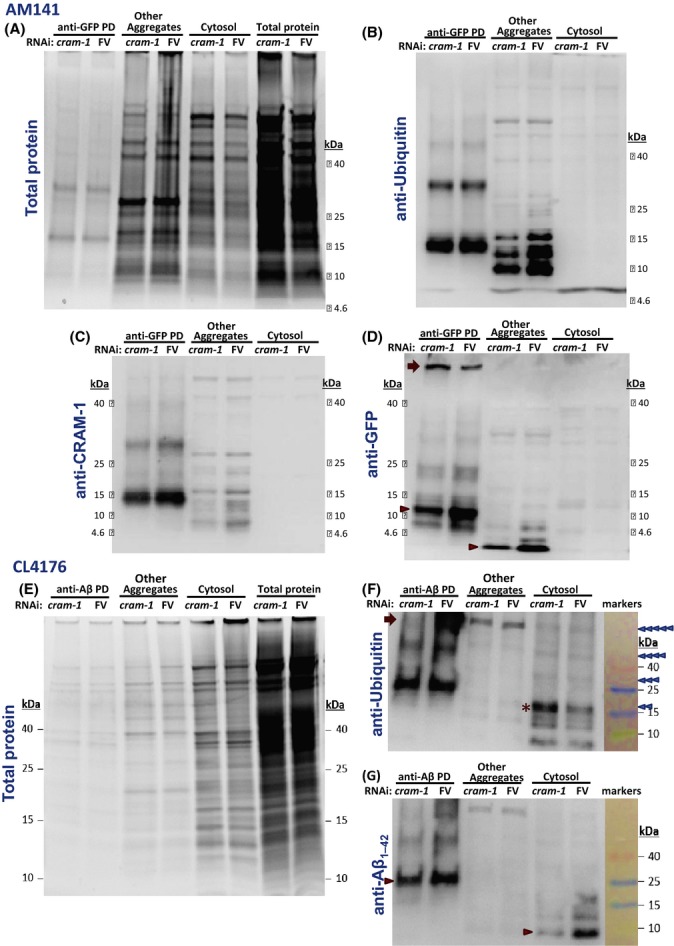
Western blot analyses of aggregated proteins from worms expressing Aβ1–42 or Q40::YFP. (A–D) AM141 worms, expressing Q40::YFP in muscle, were fed cram-1 dsRNA or FV bacteria. Aggregates were isolated and fractions resolved in gradient gel lanes (8–12%, Invitrogen). Proteins were stained with SYPRO Ruby (A), or electro-blotted to nylon membranes and probed with antibodies raised to ubiquitin (B), CRAM-1 synthetic peptides (C), or GFP/YFP (D), followed by biotinylated 2nd antibody to IgG. HRP-streptavidin was bound to biotin, and imaged by chemiluminescence (Western Blot Kit, Pierce). (E–G) CL4176 worms, expressing human Aβ1–42 in muscle, were fed cram-1RNAi or FV as above. Aggregate proteins were analyzed as above. (E) SYPRO Ruby-stained proteins or fractions, separated on 4–20% gradient gels (Bio-Rad). Small proteins such as Aβ1–42 were resolved on 16% gels (panels F, G). After blotting, nylon filters were probed with antibodies to ubiquitin (F) or Aβ1–42 (G) and detected as above. Labeled size standards are shown in panels F and G. Triangles (right) indicate expected positions for di-, tri-, tetra-, and penta-ubiquitinated Aβ1–42.